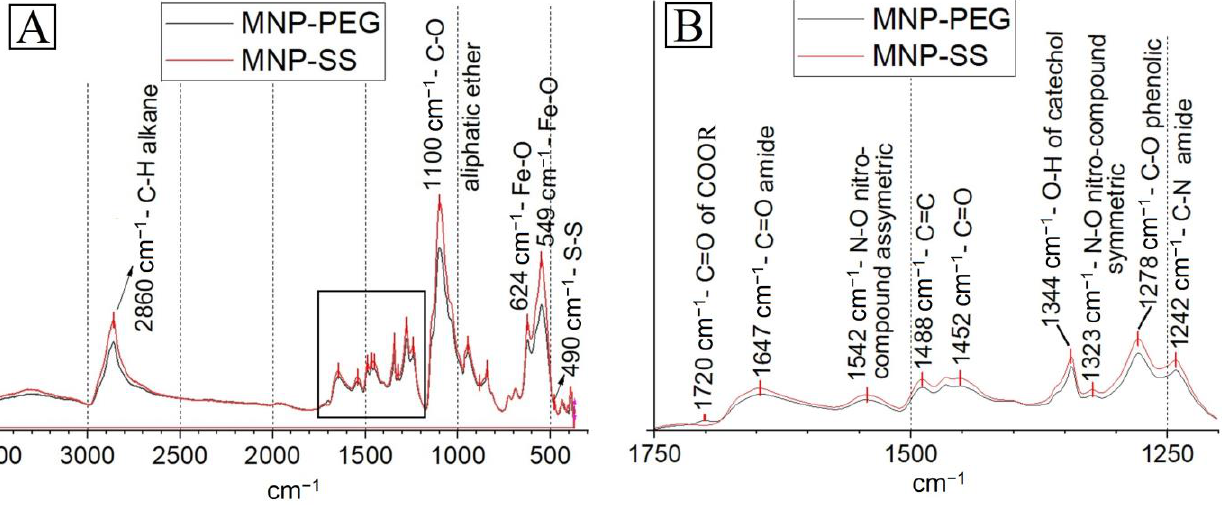
Figure 4. FT-IR spectra of the MNP-PEG and MNP-SS samples ( A ) and the same spectra at the 1750 – 1200 cm −1 range ( B ).